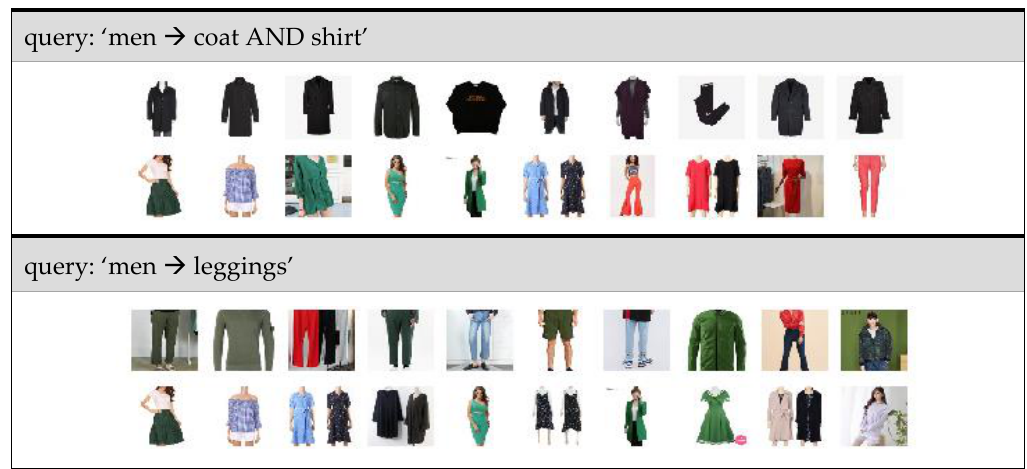
Figure 12. Search results for three different types of queries with similar or the same meaning.